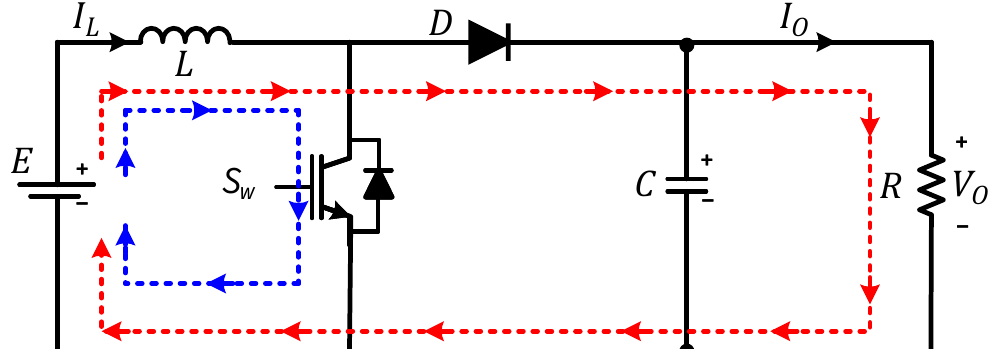
Figure 1. Boost converter (blue line: the switch is ON, red line: the switch is